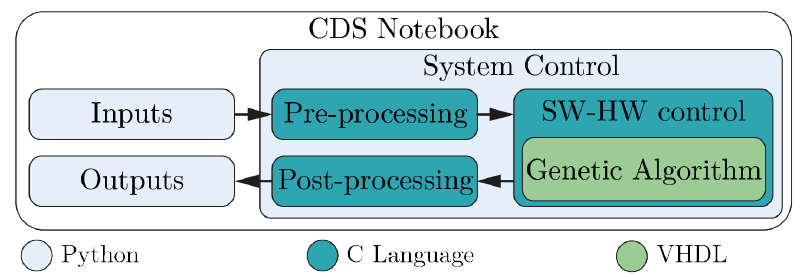
Figure 2. Block diagram of the CDS notebook